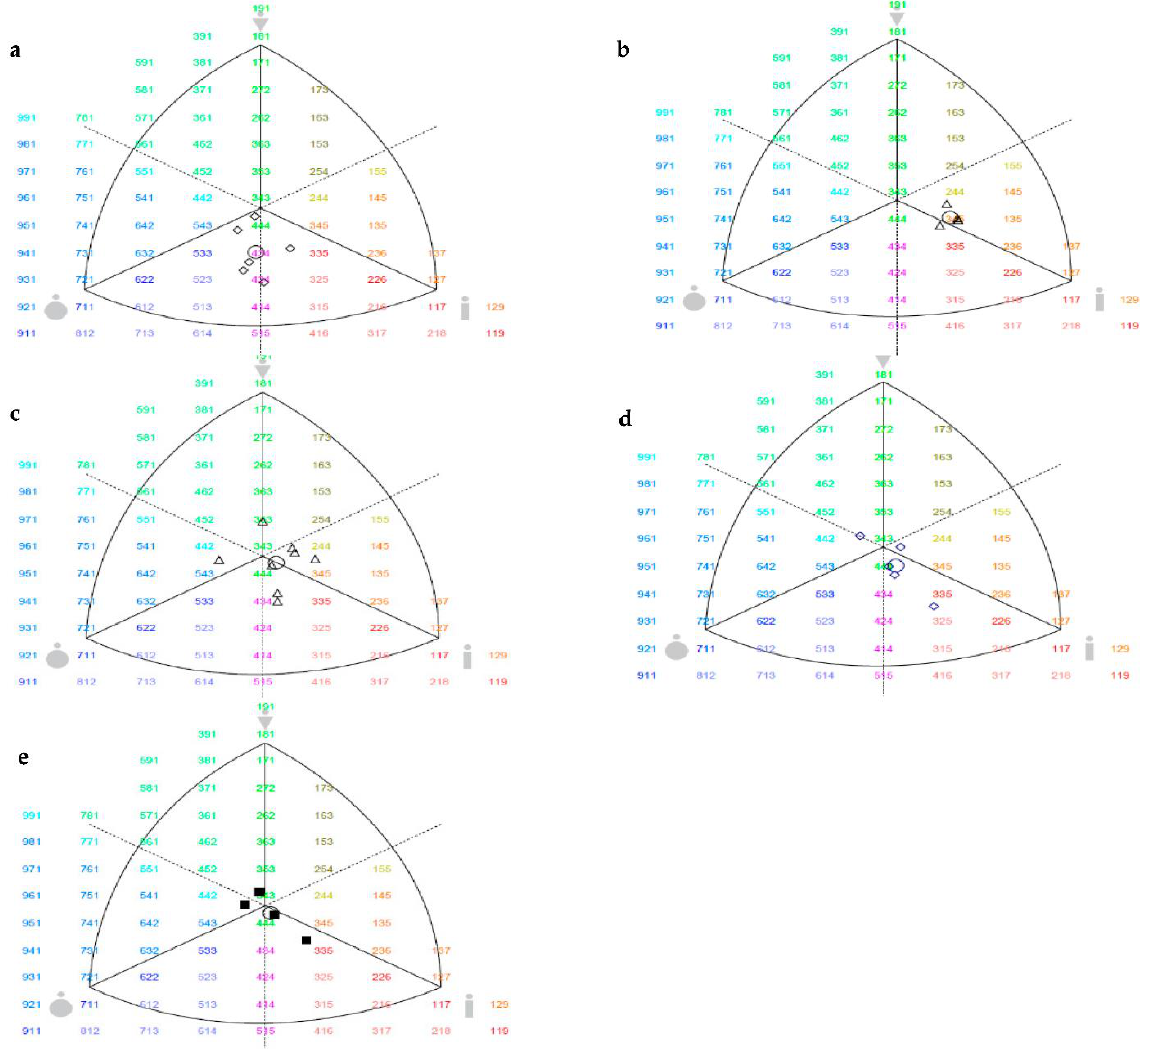
Figure 1. Individual somatotypes by the 2-D somatochart ( a ) Central midfielder, ( b ) Winger, ( c ) Defender, ( d ) Forward, ( e ) Goalkeeper. O = the mean somatotype.